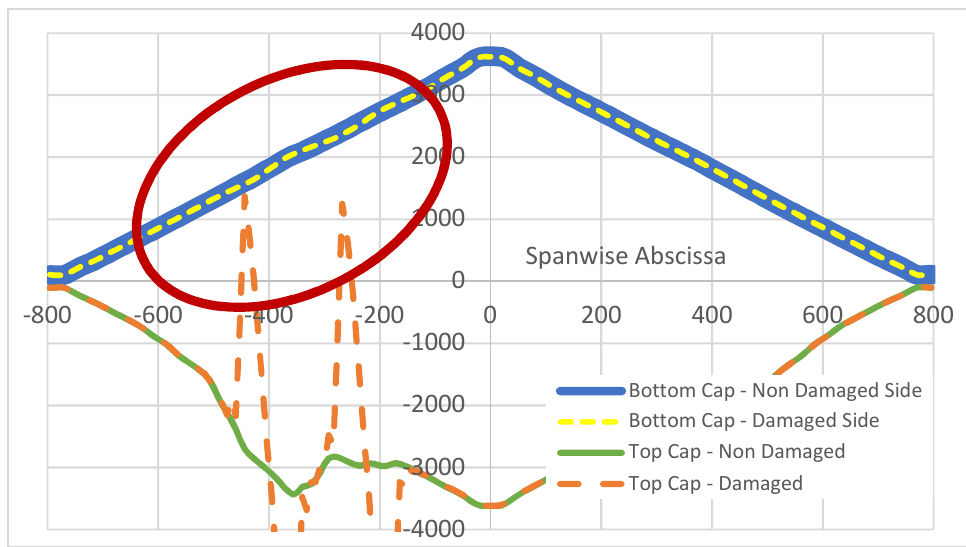
Figure 24. A comparison of the longitudinal strain functions in the bottom and top caps of the two C-spars; evidenced in the red circle, a slight modulation of the signal revealed in the bottom cap of the damaged spar.